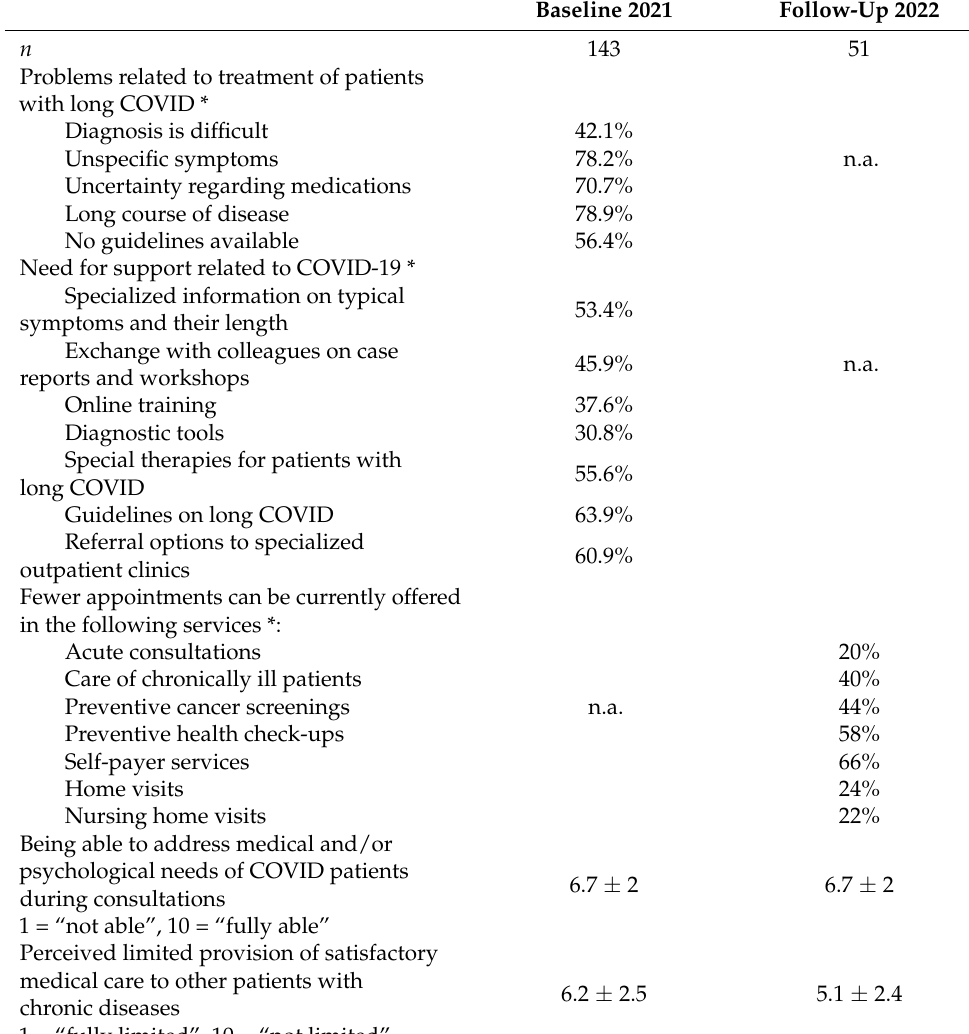
Table 4. Provision of care, current problems and need for support related to COVID-19/long COVID in GP